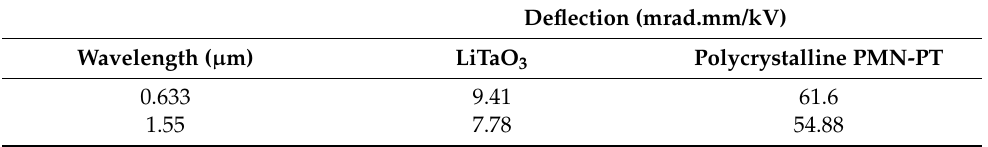
Table 7. Comparing the performance of polycrystalline PMN-PT to LiTaO 3 in deflection light at visible and